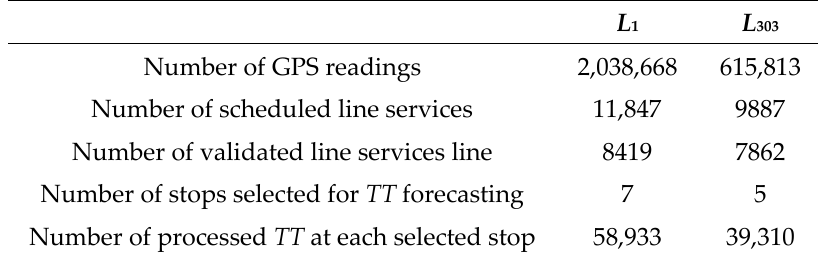
Table 3. Type and number of main data records processed in the case of